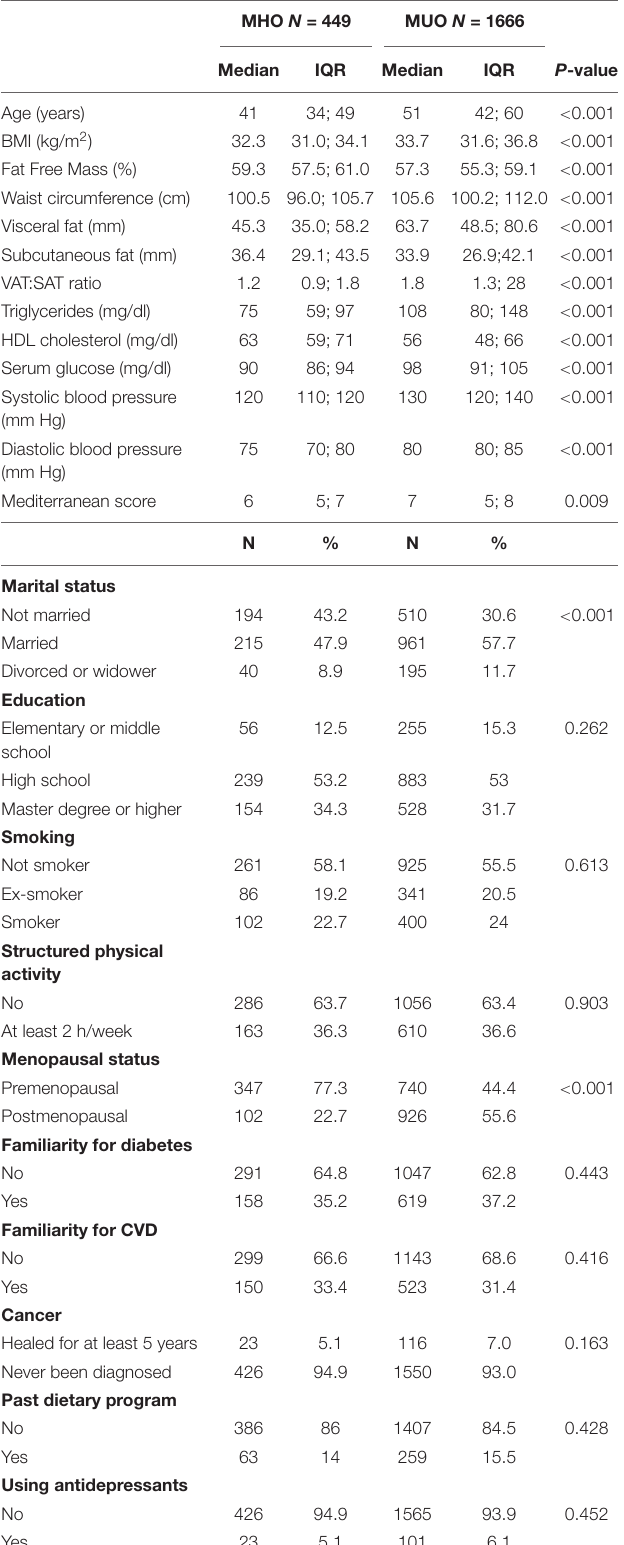
TABLE 3 | Characteristics of patients.